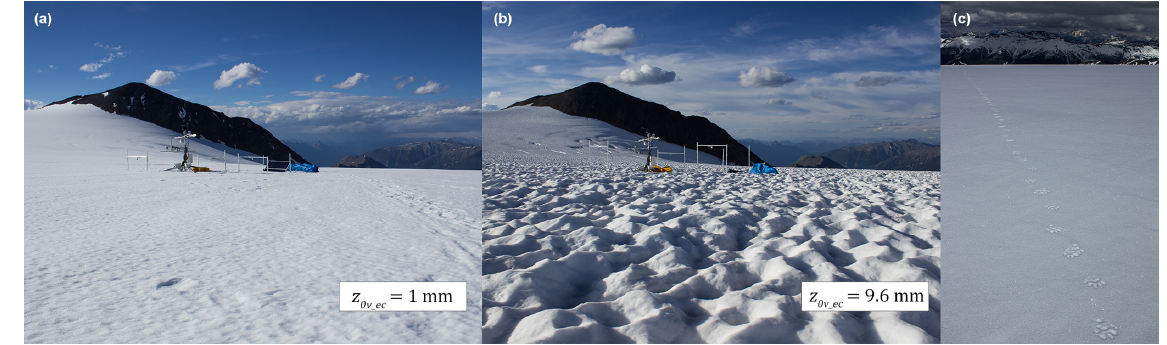
Figure 14. Observed snow surface roughness variations at CG16-2 from camera imagery for (a) 30 June–3 July ( z 0v_ec = 1 . 0 ± 4 . 2mm) and (b) 19–21 August ( z 0v_ec = 9 . 6 ± 21 . 7mm). For scale, the upper crossarm of the AWS is at a height of 1.9m. (c) Smooth snow surface observed at the location of CG16-2 on 26 April 2016 (wolverine tracks for